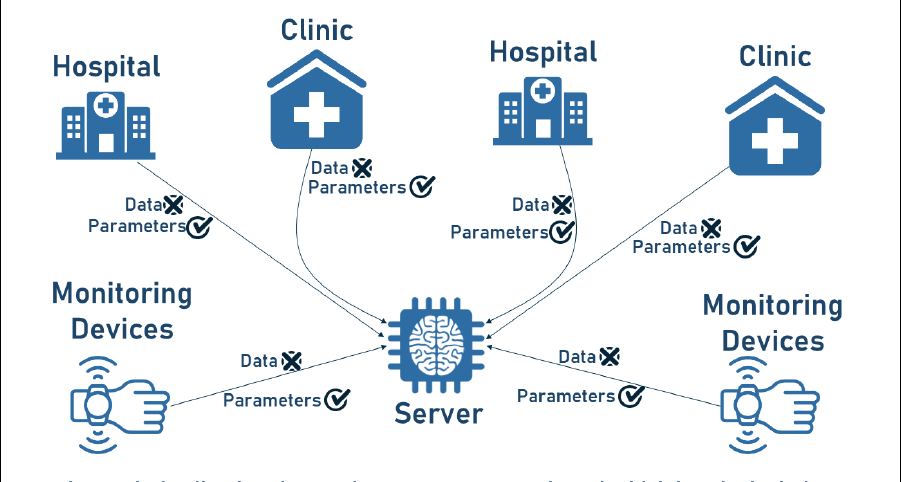
Figure 2. Data islands concept illustrated by medical